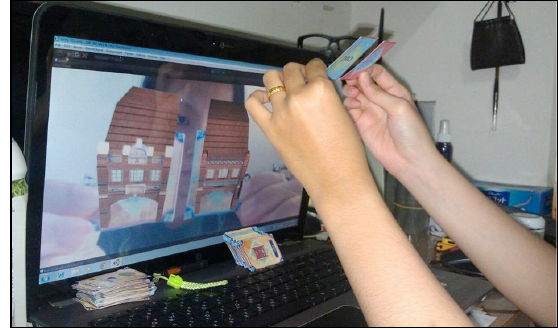
Figure 2. AR card (right) and AR imaging (left)